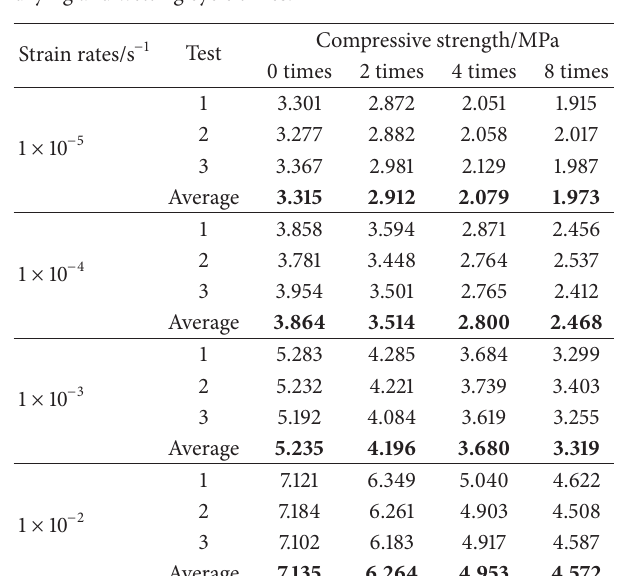
Table 2: Compressive strengths of CA mortar under different drying and wetting cycle